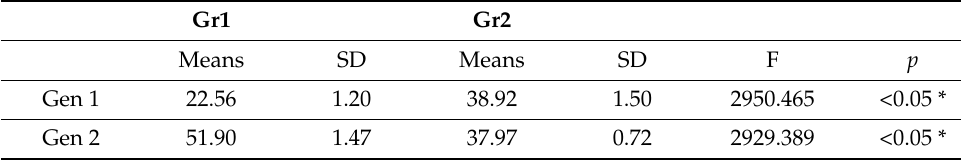
Table 4. Comparisons of mean generalization times by